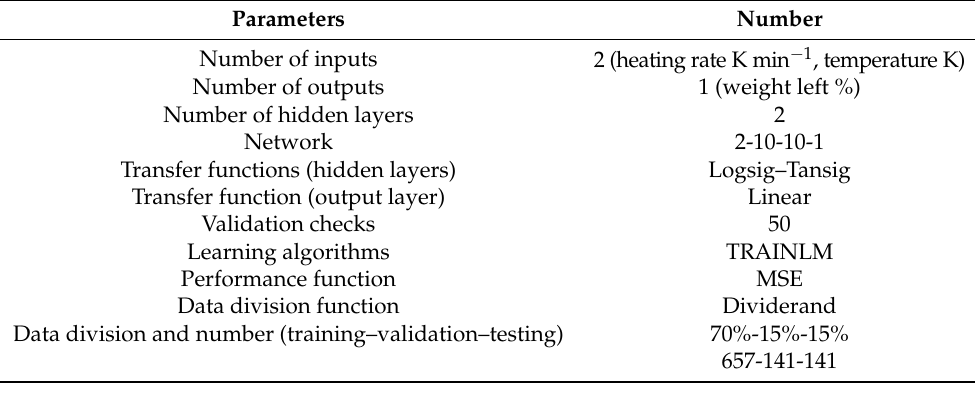
Table 1. The summary of the final ANN network.